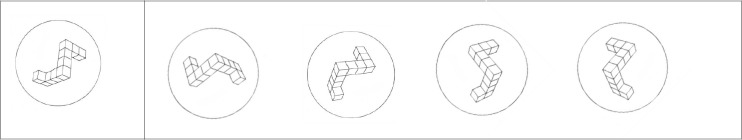
One of 16 items used for testing mental rotation performance (Quaiser-Pohl et al., 2014).